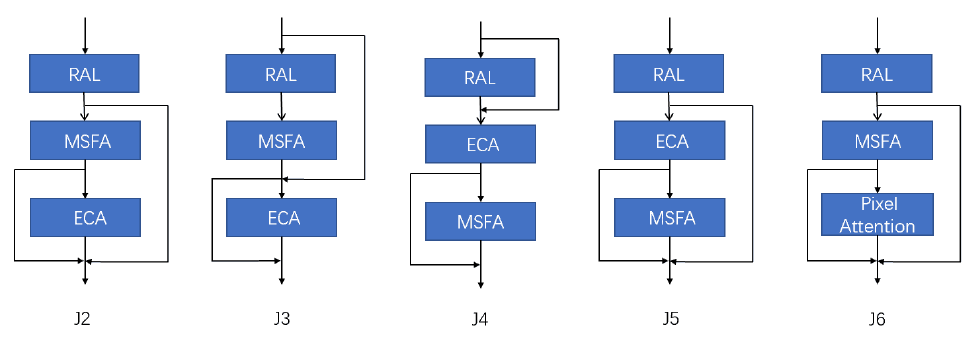
Figure 11. Flow chart of the different sequential module